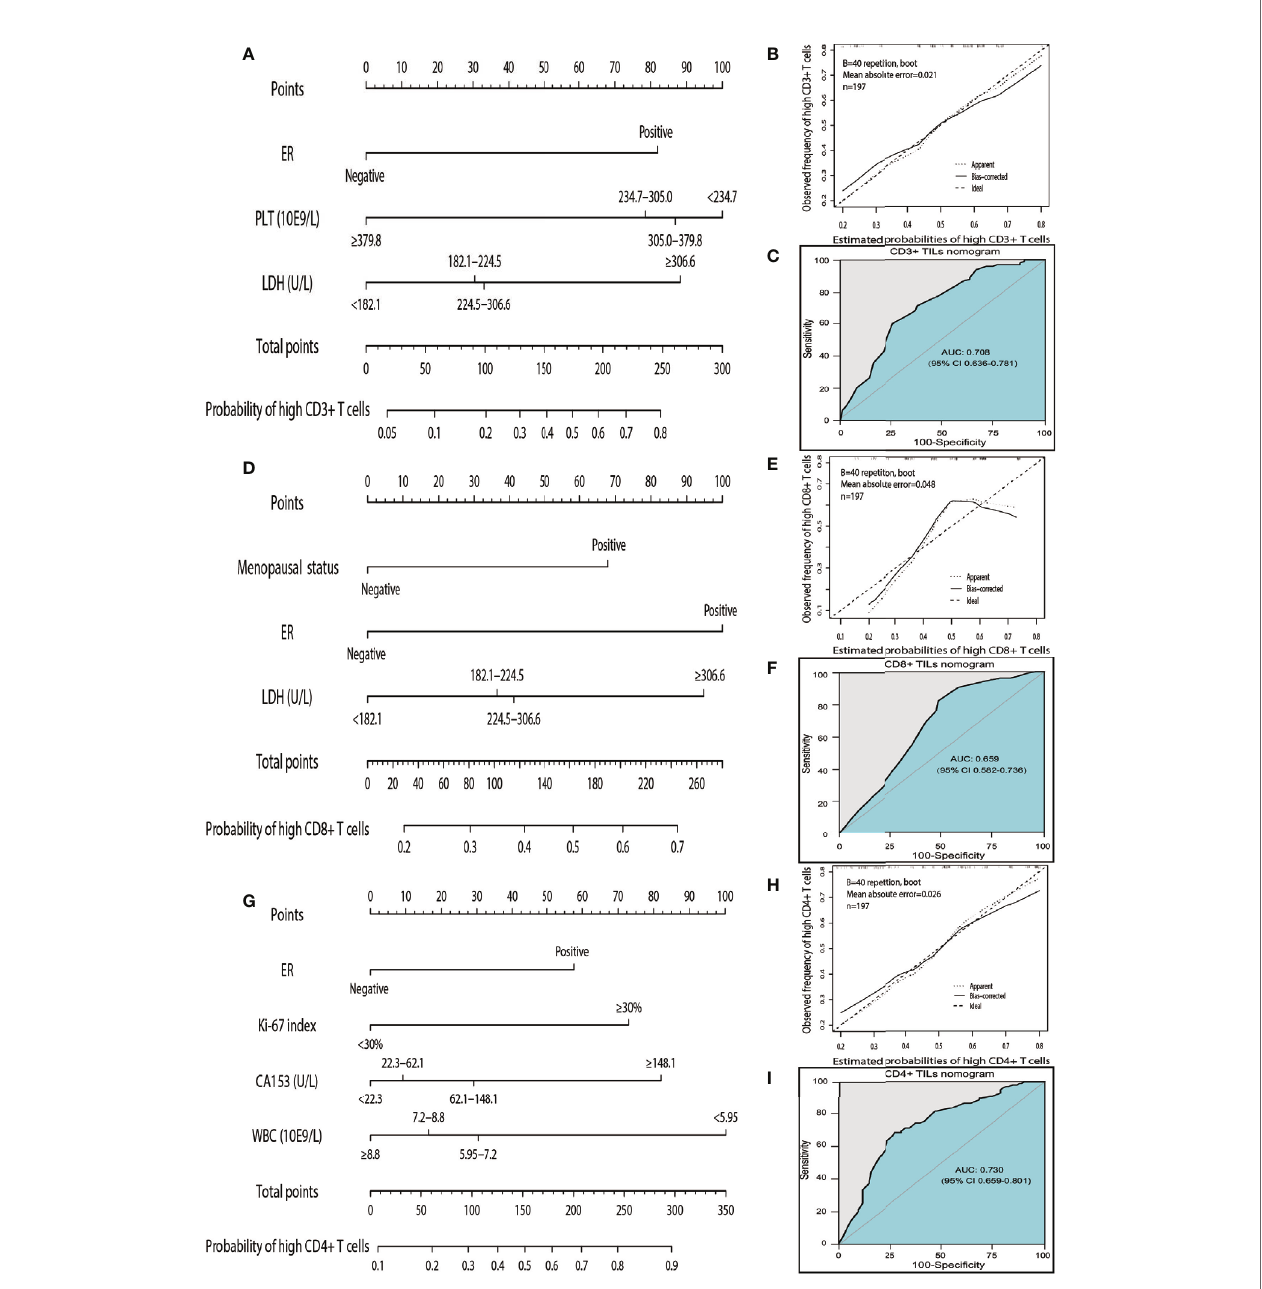
FIGURE 4 | Nomograms, calibration curves, and ROC curves analysis for predicting density of TILs in patients with high-grade serous ovarian cancer. (A) The CD3+ TILs prediction nomogram. (B) Calibration curves for predicting density of CD3+ TILs. (C) ROC curves of CD3+ TILs prediction nomogram in the internal testing set. (D) The CD8+ TILs prediction nomogram. (E) Calibration curves for predicting density of CD8+ TILs. (F) ROC curves of CD8+ TILs prediction nomogram in the internal testing set. (G) The CD4+ TILs prediction nomogram. (H) Calibration curves for predicting density of CD4+ TILs. (I) ROC curves of CD4+ TILs prediction nomogram in the internal testing set. All the points assigned on the top point scale for each factor are summed together to generate a total point score. The total point score is projected on the bottom scales to determine the probability of high density for tumor-in fi ltrating T cells in an individual. The nomogram-predicted frequency of high T cell density is plotted on the x-axis, and the actual observed frequency of high T cell density is plotted on the y-axis. The AUC was calculated, and its 95% CI was estimated by bootstrapping. TILs, tumor-in fi ltrating lymphocytes; ROC, receiver operating characteristic; 95% CI, 95% con fi dence